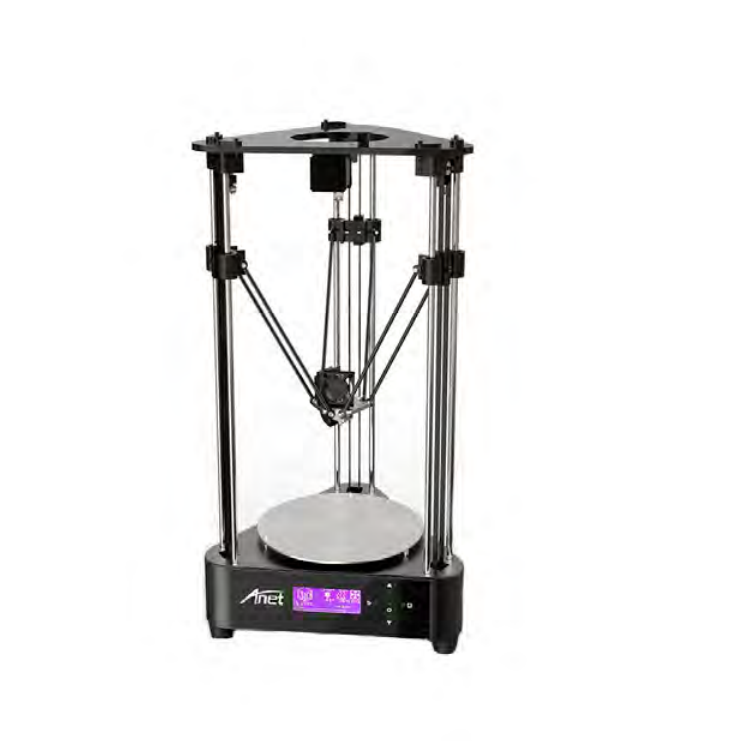
Figure 4. Delta type 3D